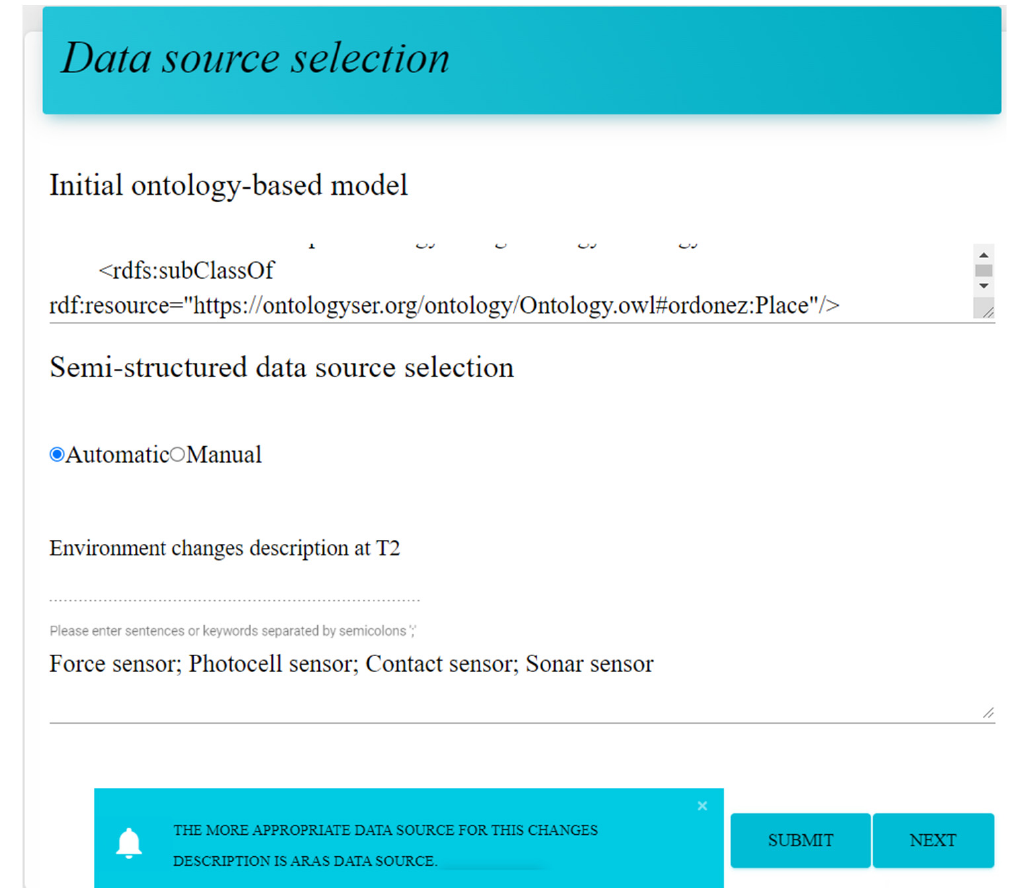
Figure 12. Candidate data source selection at t 2 of the ARAS dataset.